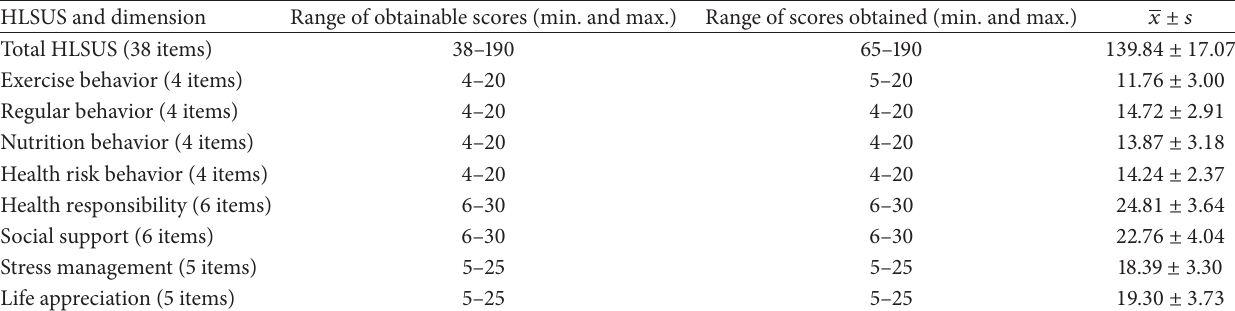
Table 2: Distribution and healthy lifestyles scale scores obtained by university students ( 𝑛 = 4908 ). HLSUS and dimension Range of obtainable scores (min. and max.) Range of scores obtained (min. and